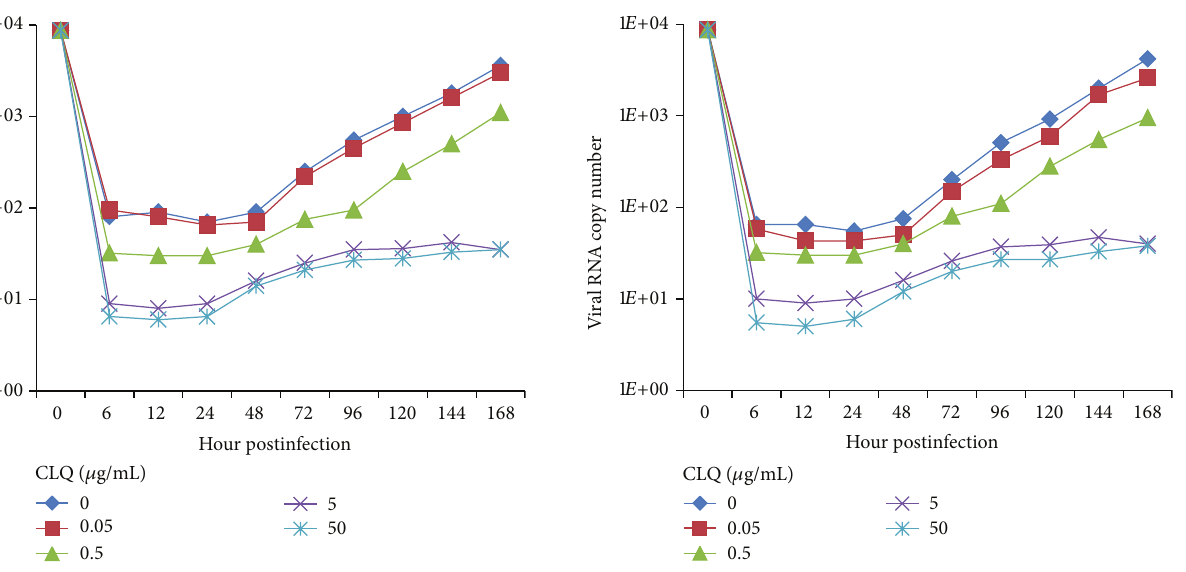
Figure 5: Action of chloroquine added at 24-hour intervals on DENV-2 replication in Vero cells. The viral RNA present in the culture supernatants of Vero cells infected with DENV-2, both untreated and treated chloroquine (every 24 hours after infection), was extracted and analyzed by qRT-PCR. The results represent the average values of the number of copies of viral RNA (𝑃 < 0.05) .